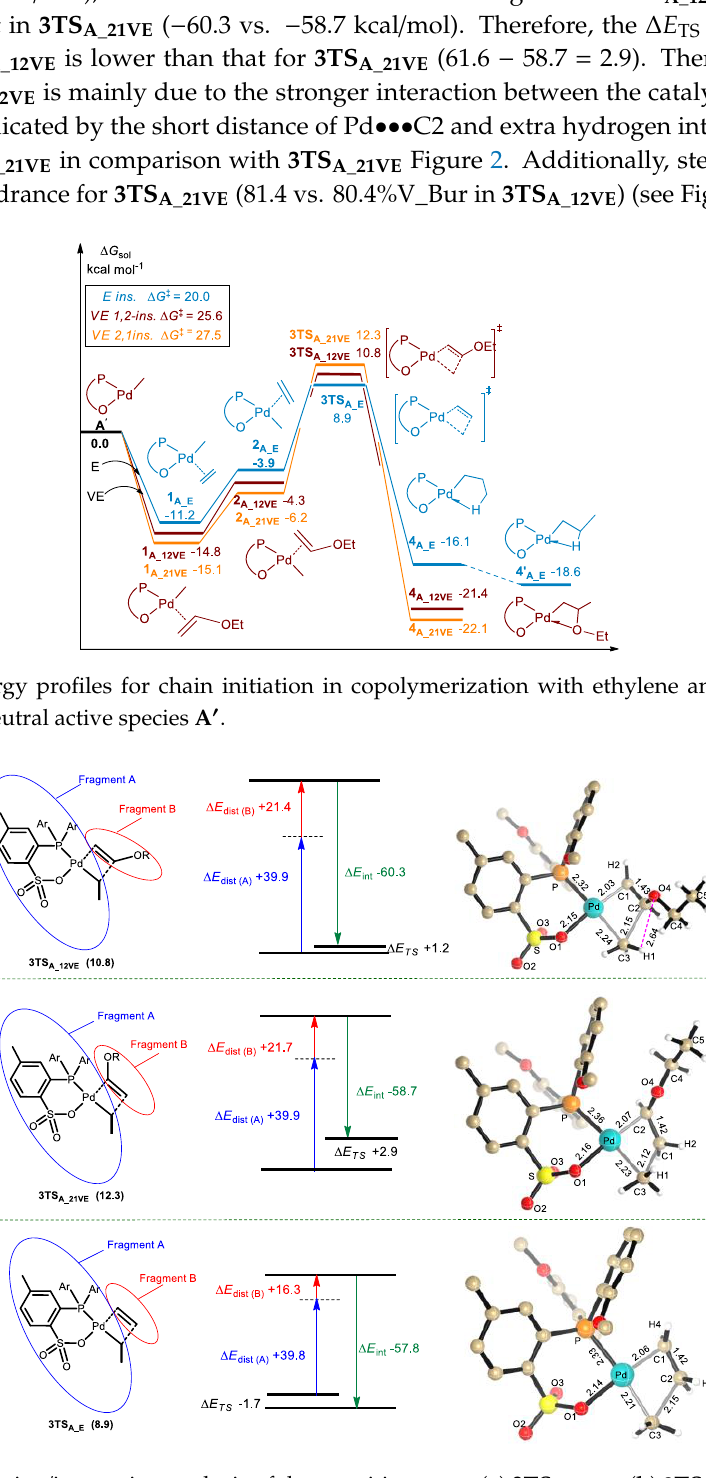
Figure 2. Distortion/interaction analysis of the transition state. ( a ) 3 TS A_12VE , ( b ) 3TS A_21VE , and ( c ) 3TS A_E . Energy in kcal / mol and distances in Å. Hydrogen atoms of the catalyst’s ligand have been omitted for clarity.